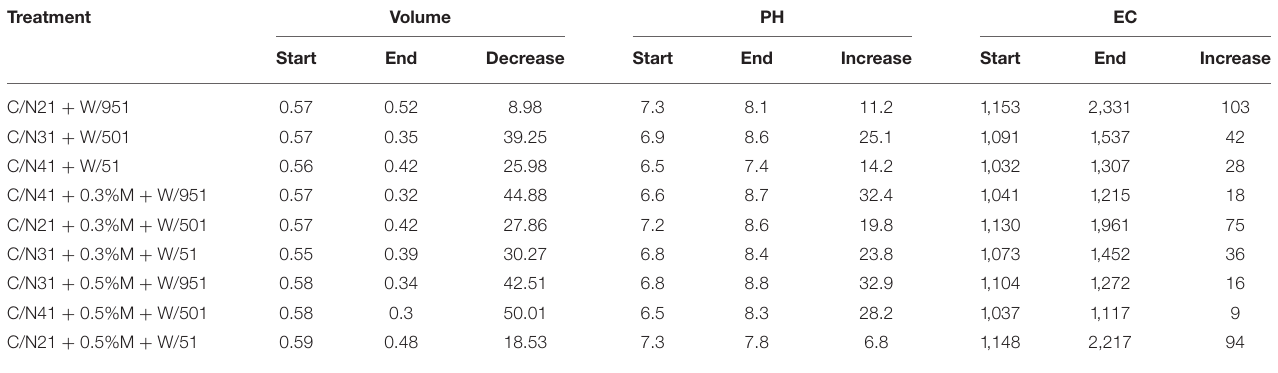
TABLE 6 | Variations of volume, pH value, and EC value of the composting at the start and the end of different treatments.